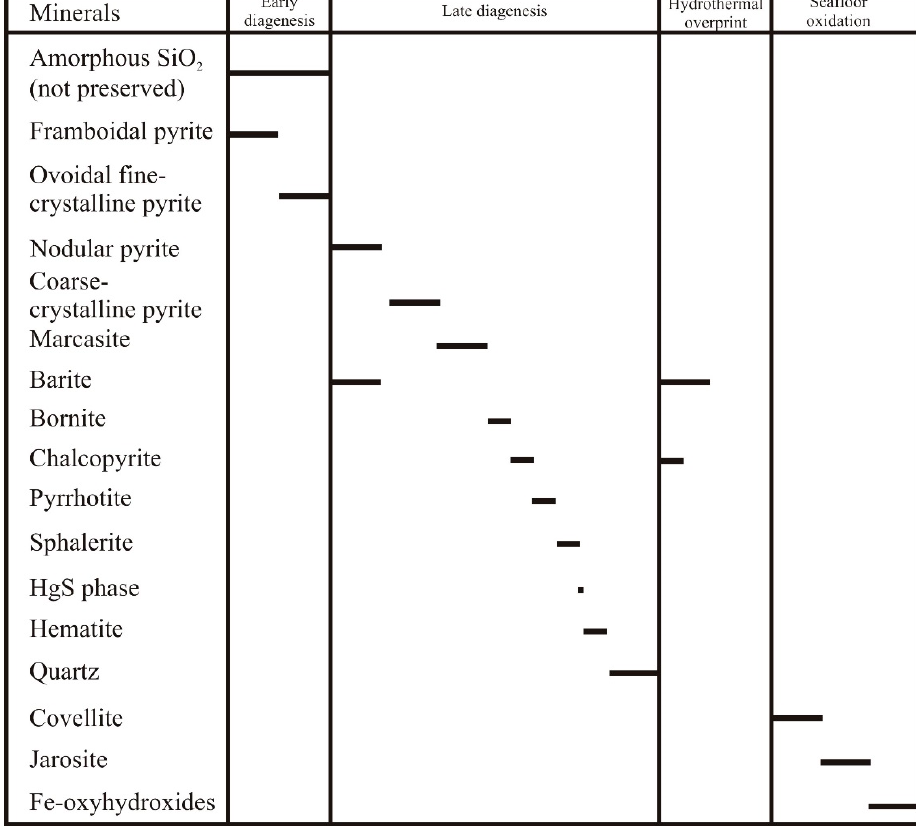
Figure 14. Paragenetic sequence of diagenetic mineral formation in sulfide breccias from the Semenov-3 hydrothermal field.